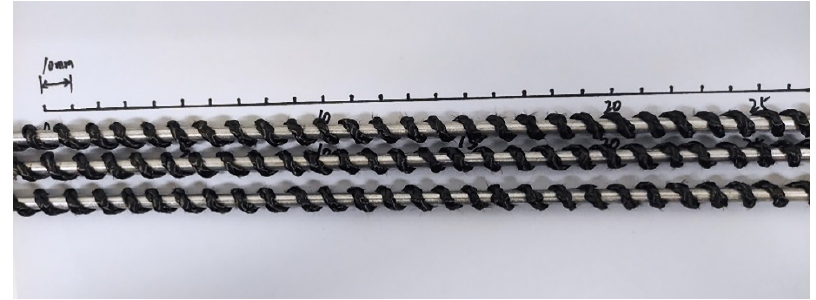
Figure 1. Helical carbon fiber prefabricated parts.